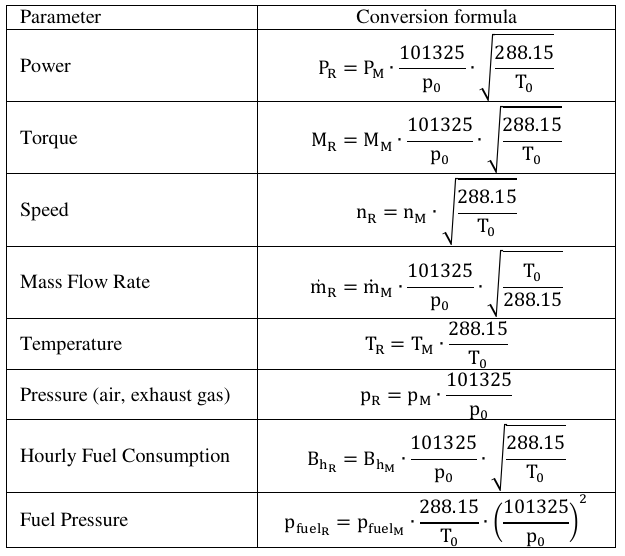
Table 2. Conversion formulas used to reduce the value of the measured parameters to standard reference state (indexes: R – reduced, M – mea-